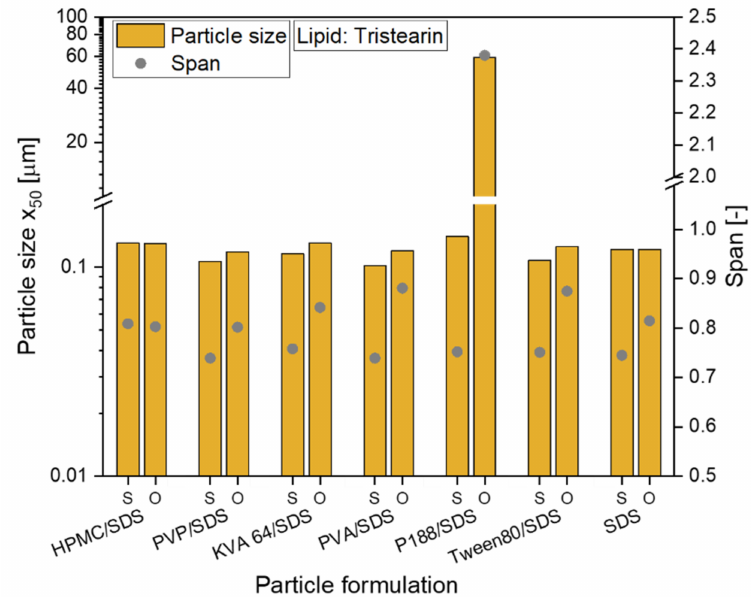
Figure 2. Investigation of the redispersiblity of differently formulated tristearin nanosuspensions from the film matrix; particle size x 50 and span of the size distribution are given for original suspen- sions (S) and for redispersed lipid particles from ODFs